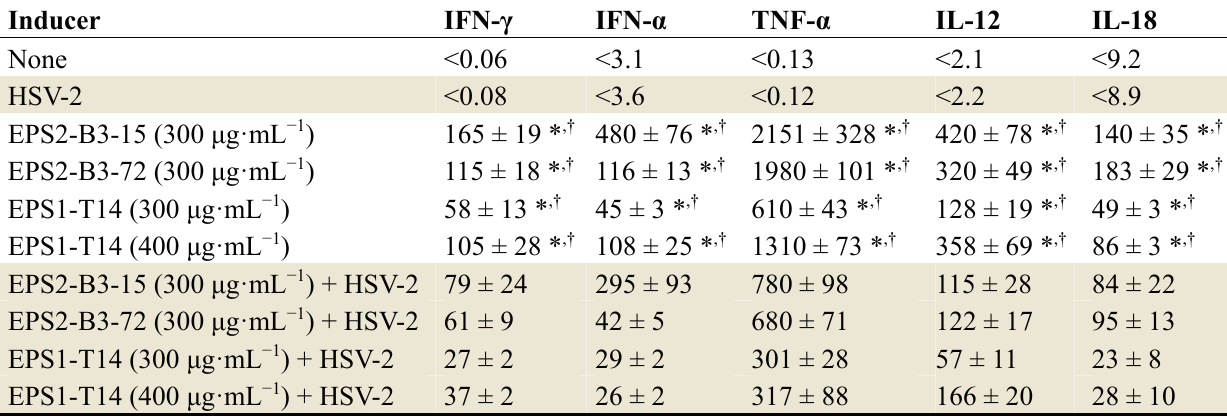
Table 5. Production of Th-1 cytokines (pg·mL − 1 ) at 48 h post-EPSs treatments by PBMC and under the effect of HSV-2 infection (in grey). Values are expressed as the mean of four experiments ±S.D. IFN- γ